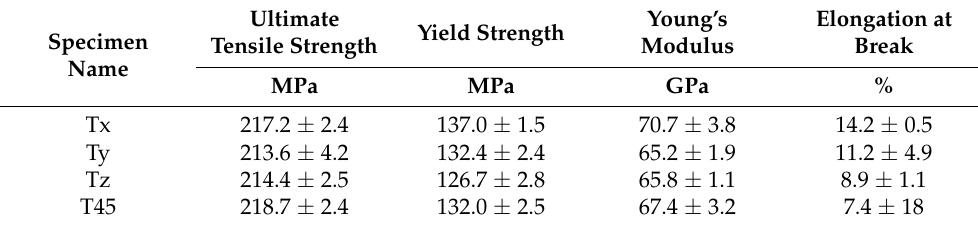
Table 4. Tensile test results of AlSi10Mg specimens built in different